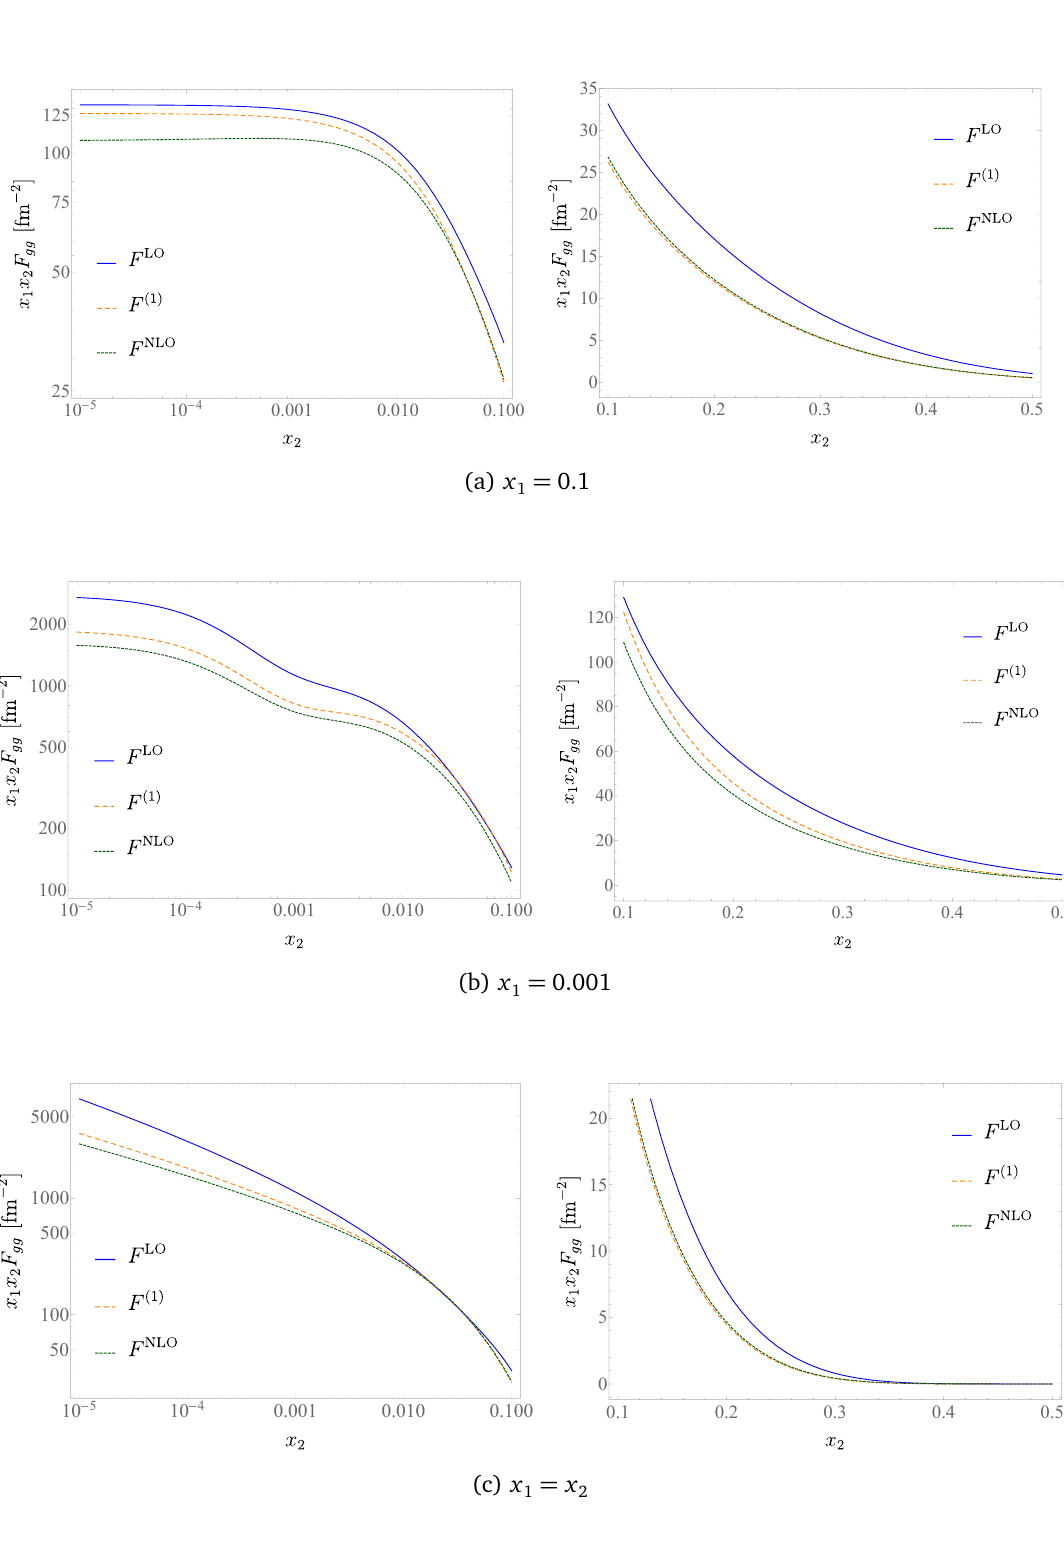
Figure 7: Splitting contribution to the two-gluon DPD at y = 0.022fm computed at LO or at NLO, as well as the between F LO and F ( 1 ) is the order at which a